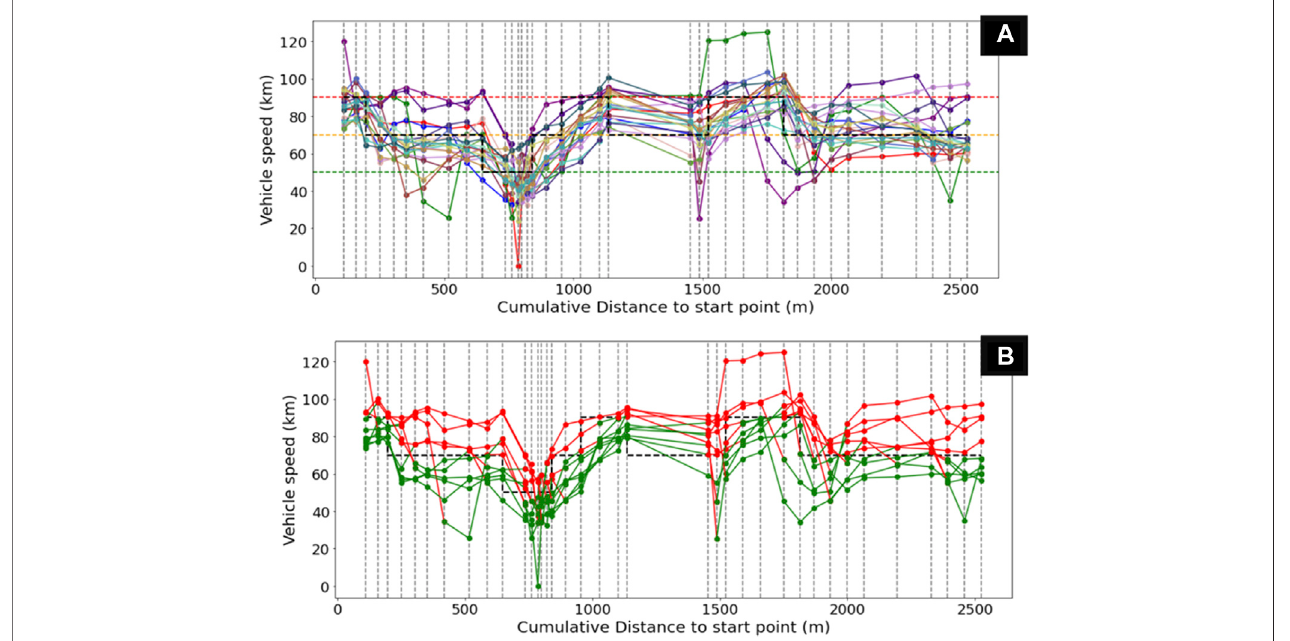
FIGURE 7 | Illustration of the speed variations of some trips with to speed